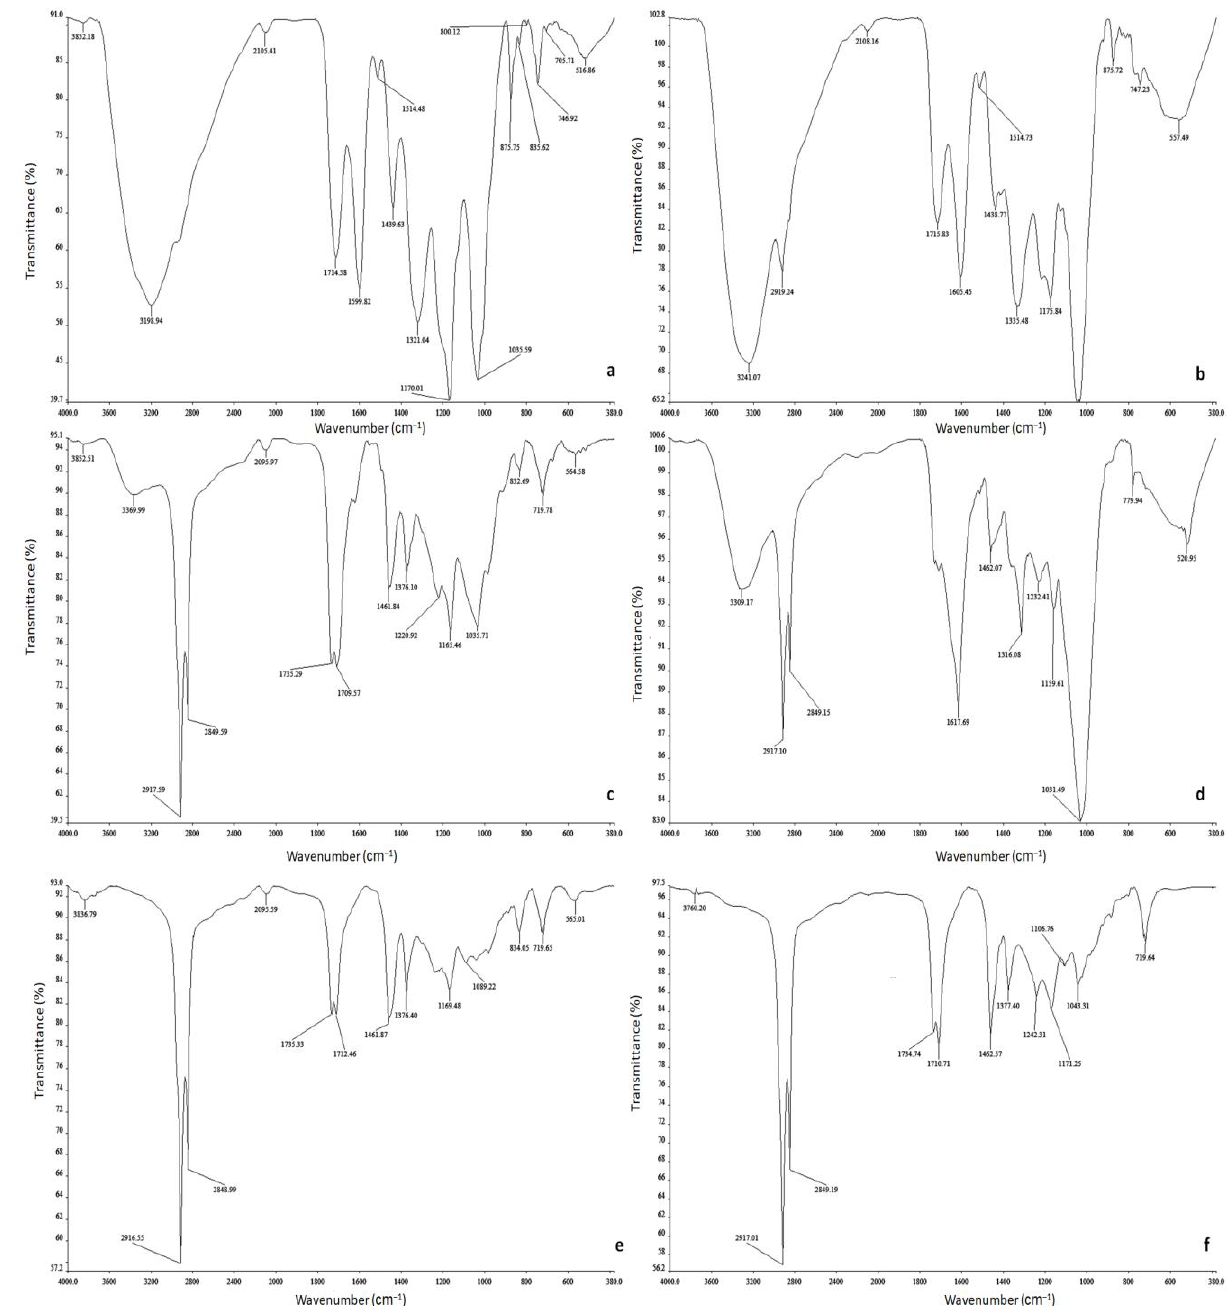
Figure 6. FT – IR spectra of crude plant extracts of D. villosa ( a ) crude leaf methanol extract; ( b ) crude stem-bark methanol extract; ( c ) crude leaf chloroform extract; ( d ) crude stem-bark chloroform extract; ( e ) crude leaf hexane extract; ( f ) crude stem-bark hexane extract at room temperature (24 °C).